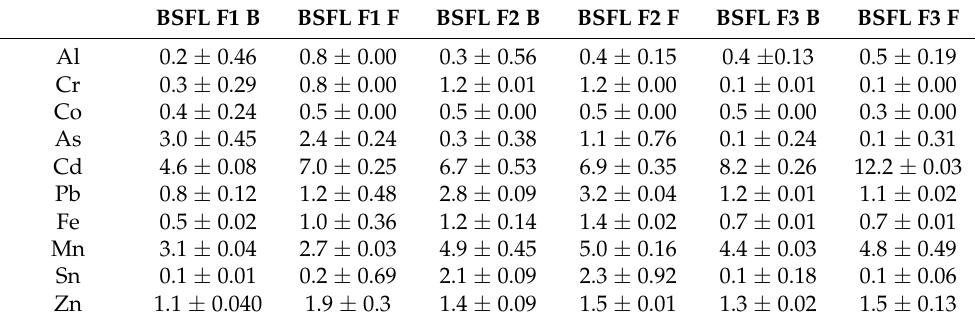
Table 5. The bioaccumulation factor (means and SD) for select heavy metals for BSFL grown on three different feeds and killed by freezing or blanching ( p <